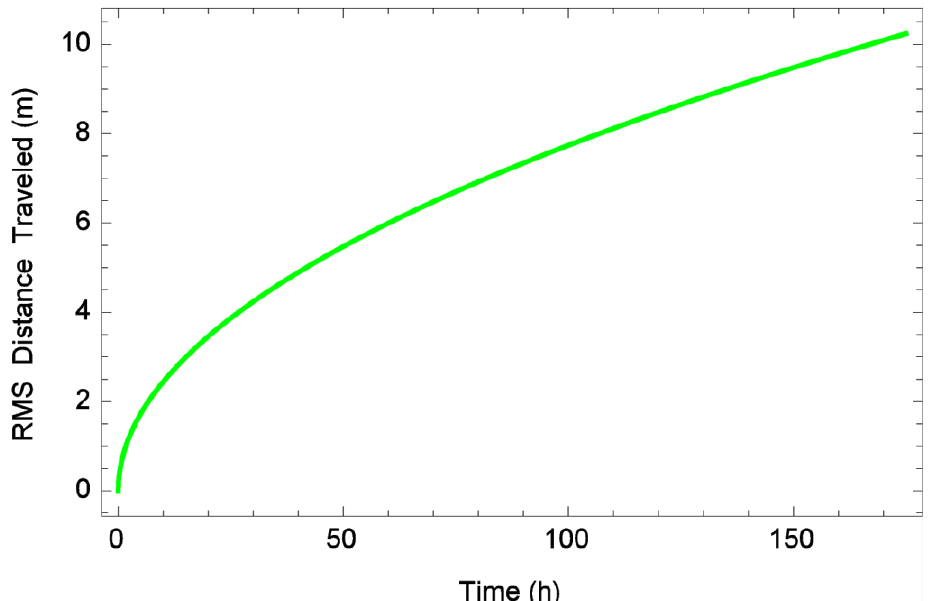
Figure 9. Time (h) versus predicted root mean squared distance (m) traversed by an individual bed bug dispersing at the maximum (over all reps) observed diffusion rate of 0.416 cm 2